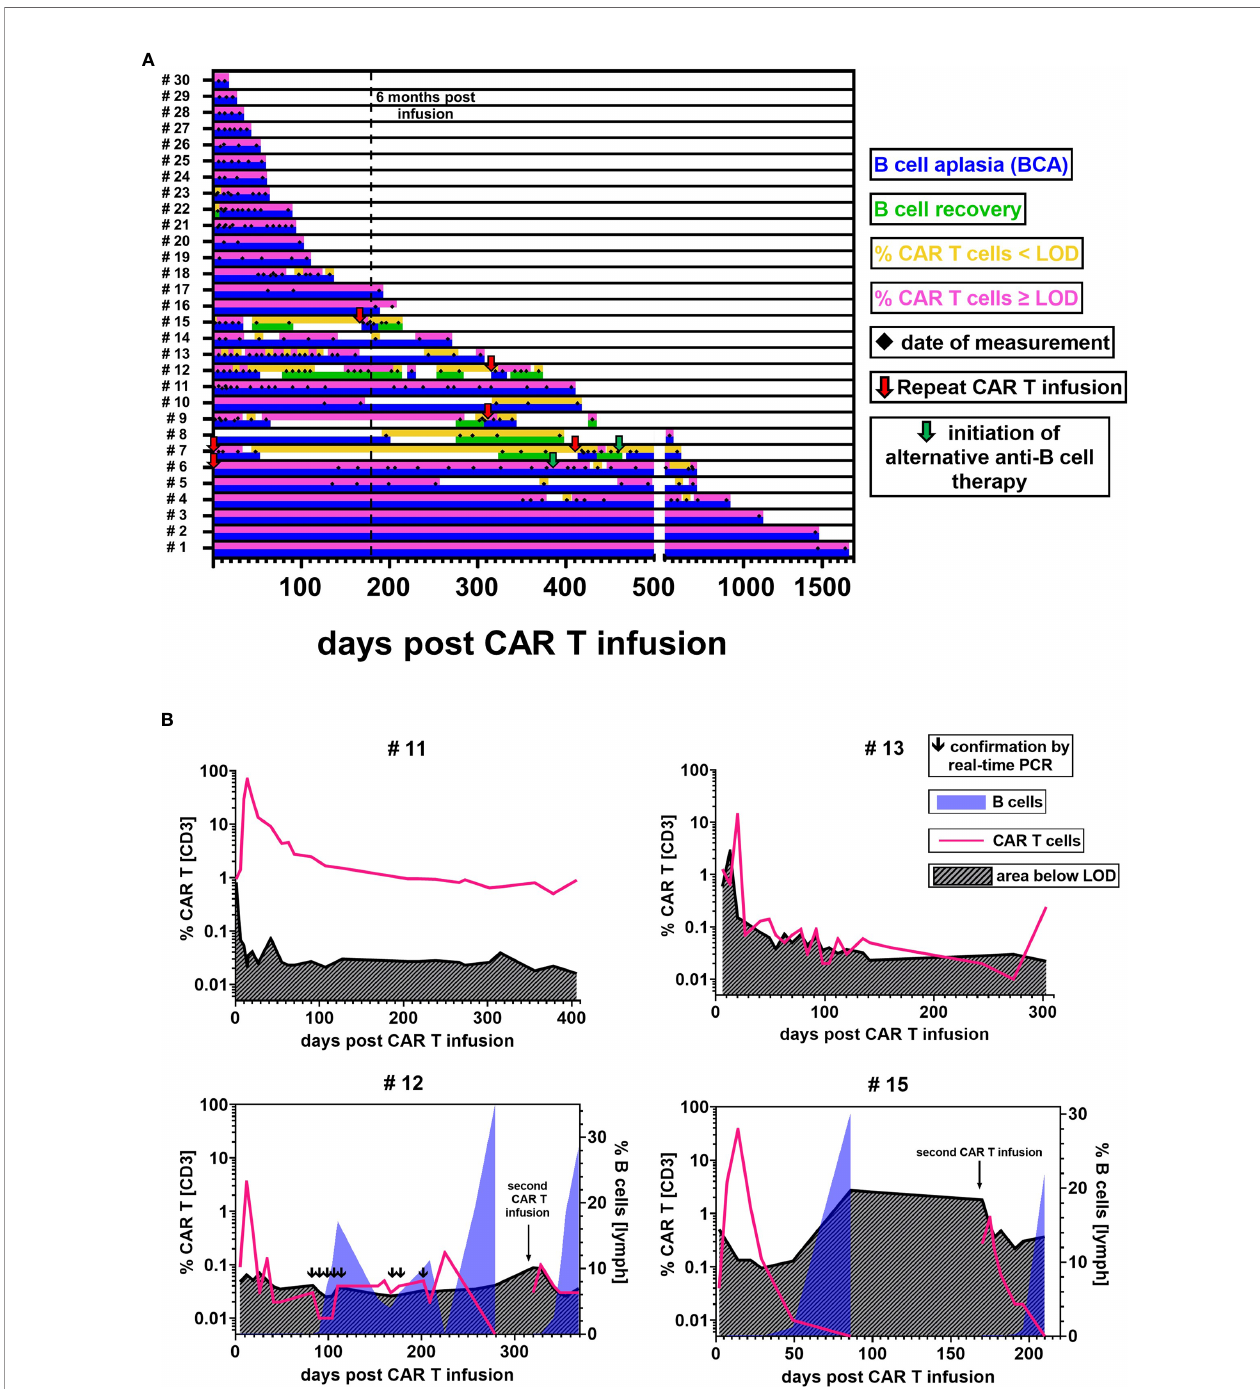
FIGURE 5 | CAR T cell detectability and functional persistence. (A) Each lane illustrates the CAR T cell (upper sublane) and B cell (lower sublane) monitoring results for the follow-up of one individual patient. Measurement time points are represented by black diamonds in the center. Periods of CAR T cell frequencies above LOD (pink) and below LOD (yellow) were distinguished to evaluate detectability. Functional CAR T cell persistence was assessed by monitoring B cell levels. Periods with B cells ≤ 0.2% were regarded as BCA (blue). B cell recovery (green) was de fi ned as an increase of the percentage of B cells > 0.2%, starting from the fi rst result with detectable B cells ≥ 0.1%. Red arrows indicate repeat CAR T cell infusions. Green arrows denote the initiation of an alternative anti-B cell therapy. In two patients, day 0 is marked as repeat infusion because our monitoring began at their second infusion. (B) Representative curves of CAR T cell monitoring results and their current detection limit as calculated based on our experimentally established LOD of 13 fl ow cytometric events. Blue overlay areas indicate the recovery of B cells if